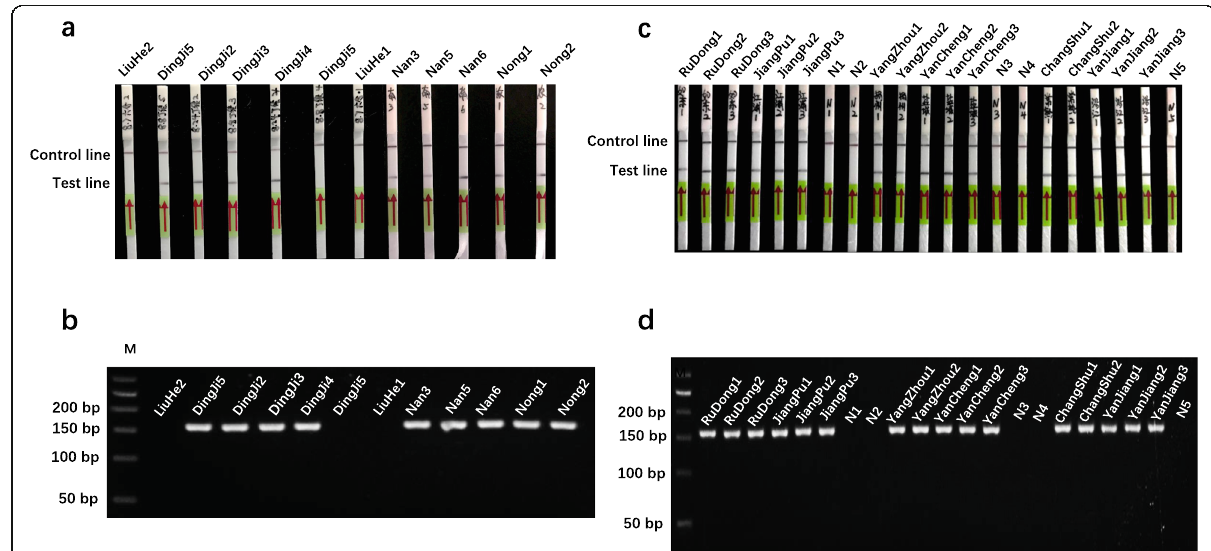
Fig. 4 Application of the RPA-LFD assay in BCMV-infected legumes. a Twelve suspected BCMV-infected soybean samples were detected by RPA- LFD assay. b The same soybean samples tested in a were detected by PCR method. c Twenty-one adzuki bean samples were tested by RPA-LFD. d The same adzuki bean samples used in c were tested by